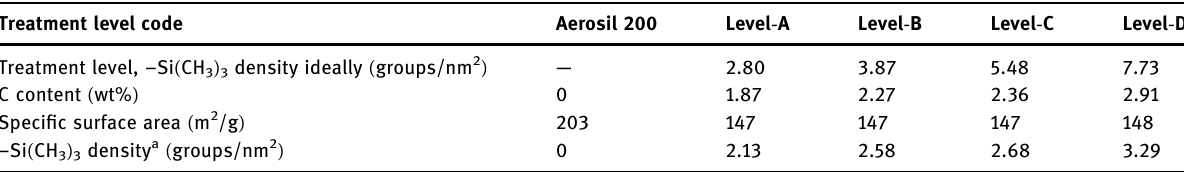
Table 2: Characterization of untreated and treated hydrophobic silica surface Treatment level